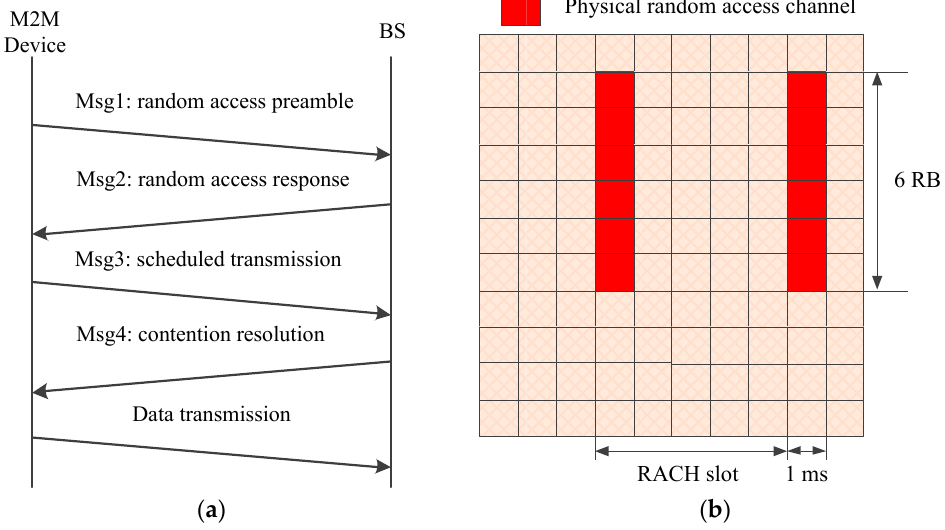
Figure 1. Contention-based random access procedure and physical random access channel: ( a ) Contention based random access procedure; ( b ) Physical random access